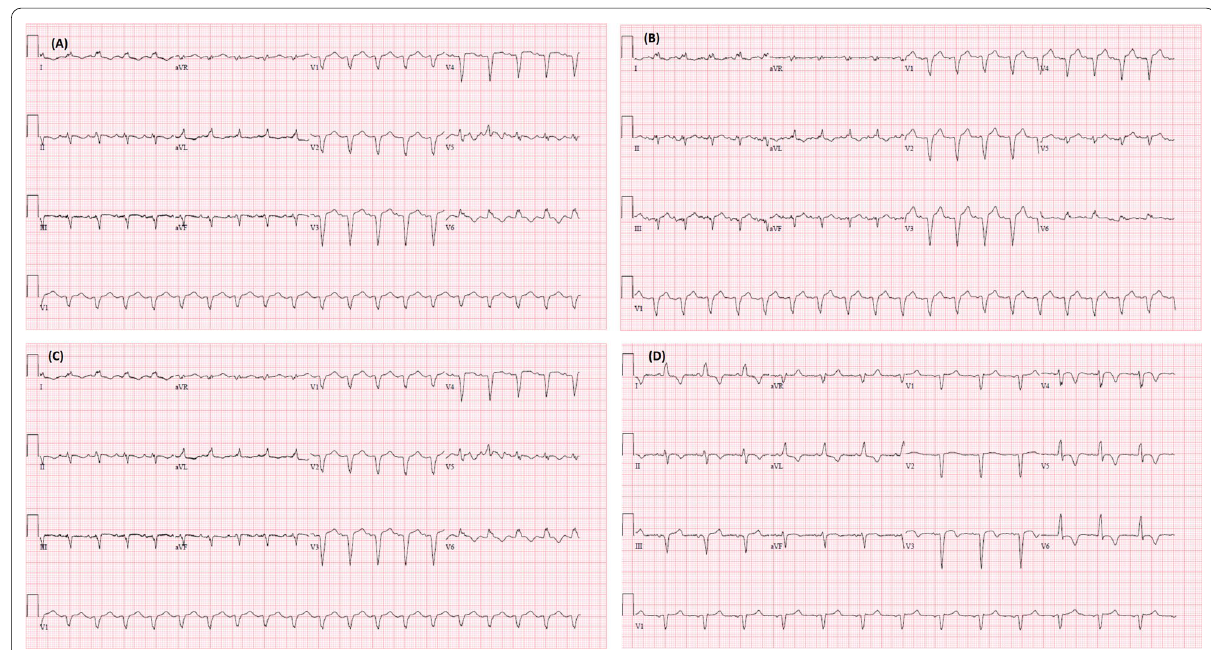
Fig. 1 EKG changes during the course of admission. A EKG on admission showing ST elevation in inferior and anterolateral leads. B EKG 1.5 h later showing same ST elevation in the inferior and anteriolateral leads, and left axis deviation. C EKG 18 h later showing new left bundle branch block. D EKG 6 days after admission showing resolution of Left Bundle Branch Block